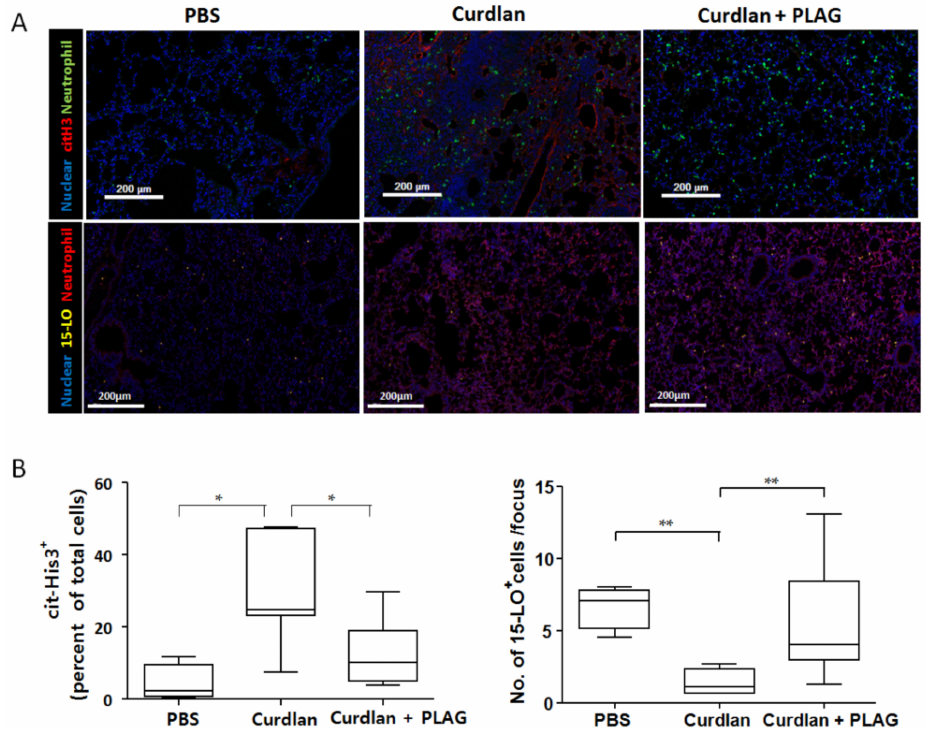
Figure 4. Opal multiplexed immunofluorescent images and semi-quantitation of the citrullinated histone 3 and 15-lipoxygenase expression in the lung tissue. ( A ) Opal multiplexed immunoflu- orescent images showed the citrullinated histone 3 + cells and 15-lipoxygenase + cells in the lung tissue. ( B ) Compared with the curdlan-induced SKG mice, a lower density of citrullinated histone 3 + cells and a higher density of 15-lipoxygenase + cells were shown in the curdlan-induced SKG mice with PLAG treatment, suggesting the resolution of NETosis. The values represent the mean of three independent experiments ± SEM. * p < 0.05; ** p < 0.01. cit-His3: citrullinated histone 3; 15-LO: